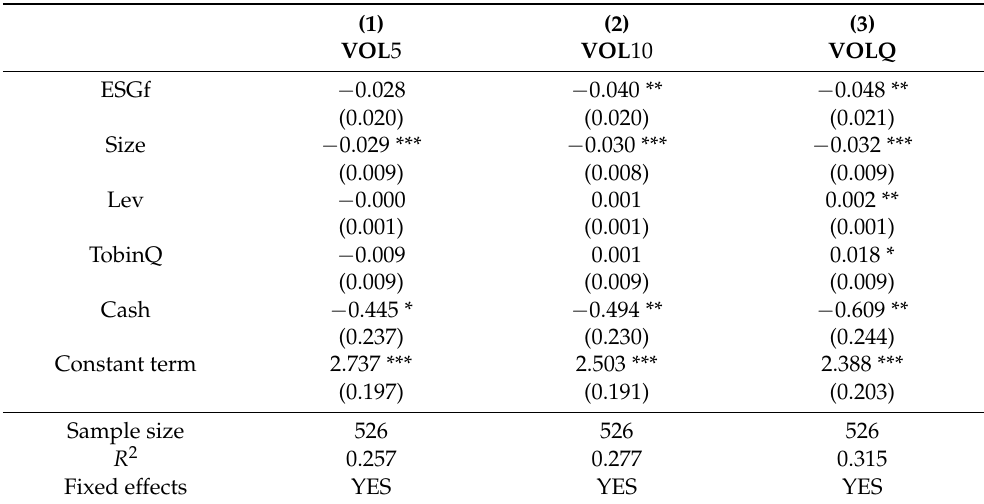
Table 6. Change the subsample selection